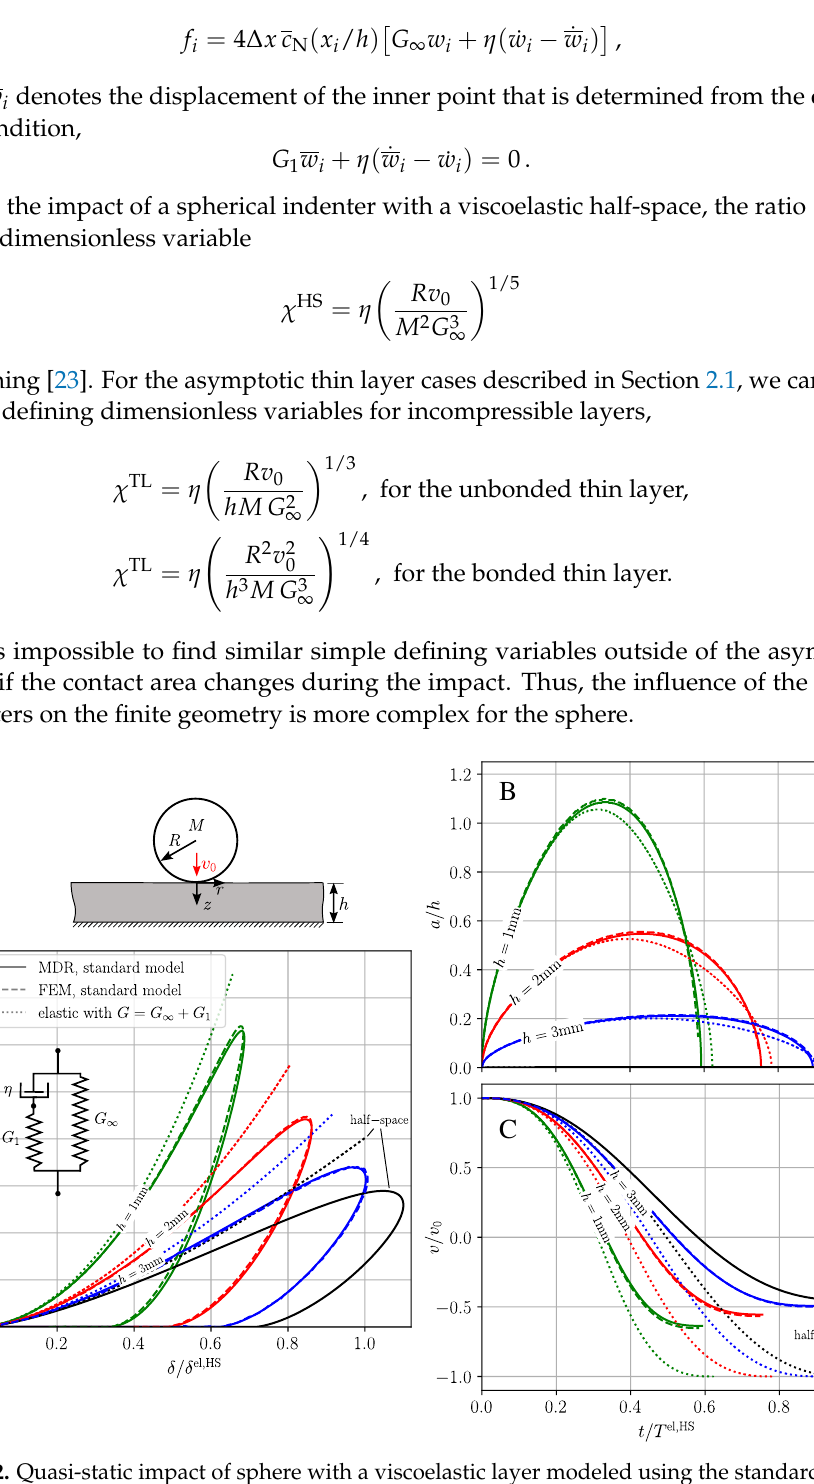
Figure 12. Quasi-static impact of sphere with a viscoelastic layer modeled using the standard model; ( A ) normal force vs. indentation depth; ( B ) confinement ratio a / h vs. impact time; ( C ) indenter velocity vs. impact time; normal force, indentation depth and impact duration are normalized with the corresponding maximum values of the elastic